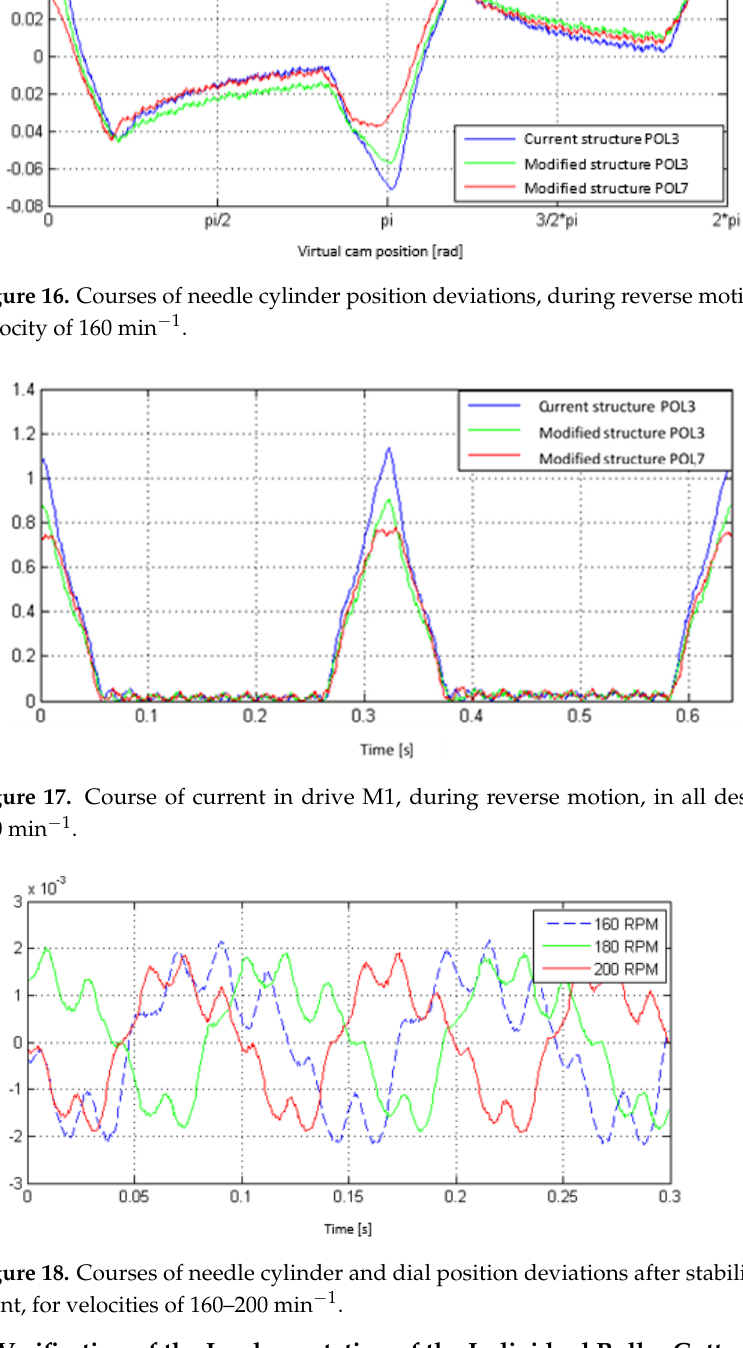
Figure 18. Courses of needle cylinder and dial position deviations after stabilization of their move- ment, for velocities of 160–200 min − 1 .